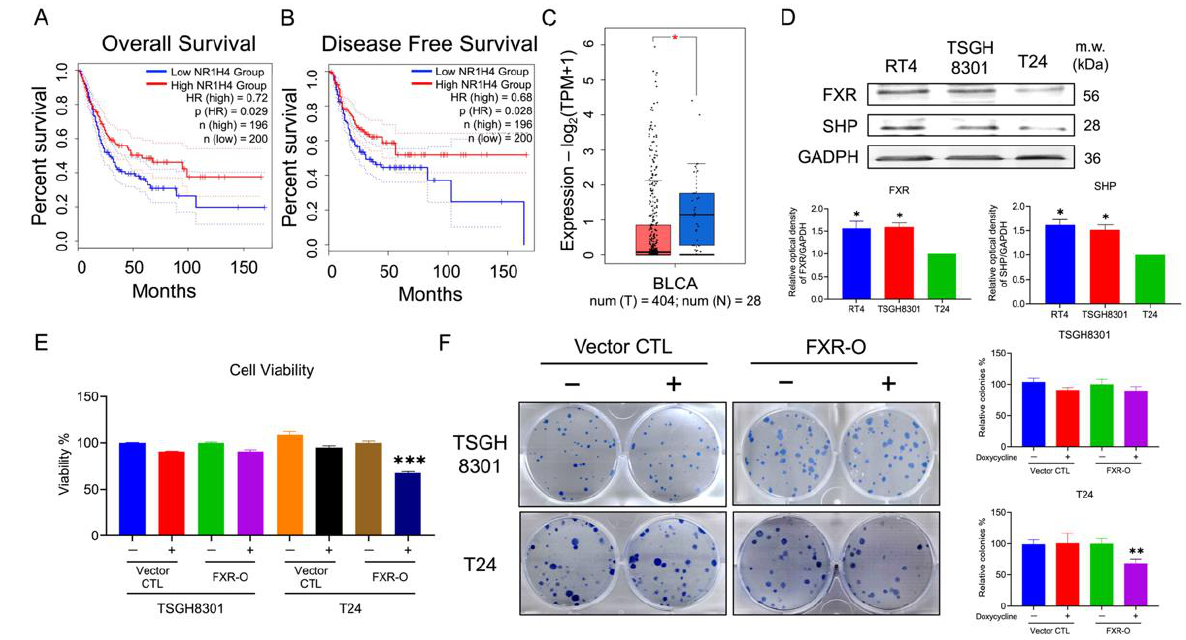
Figure 1. Farnesoid X receptor (FXR) expression and the effects on cell viability in human bladder cancers. ( A , B ) Overall and disease-free survival rate in differential expression of NR1H4 (FXR) gene in TCGA database of bladder cancer patients. ( C ) Scatter plots in differential expression of FXR gene in TCGA database of bladder cancer tissues (red plot) and adjacent normal tissues (blue plot). * p < 0.05 compared with the bladder cancer tissues group. ( D ) The expression levels of FXR and SHP in the bladder cancer cell lines were analyzed by Western blotting. GAPDH was a loading control. * p < 0.05 compared with the T24 group. ( E ) The survival rate of TSGH8301 and T24 were analyzed after doxycycline induced for 72 h in vector control and FXR overexpressed groups using MTT assay. ( F ) Colony formation assay of TSGH8301 and T24 were analyzed after 9 days of doxycycline induction in vector control and FXR overexpressed groups. Wells were visualized and quantified. ** p < 0.01; *** p < 0.001 compared with the control group.